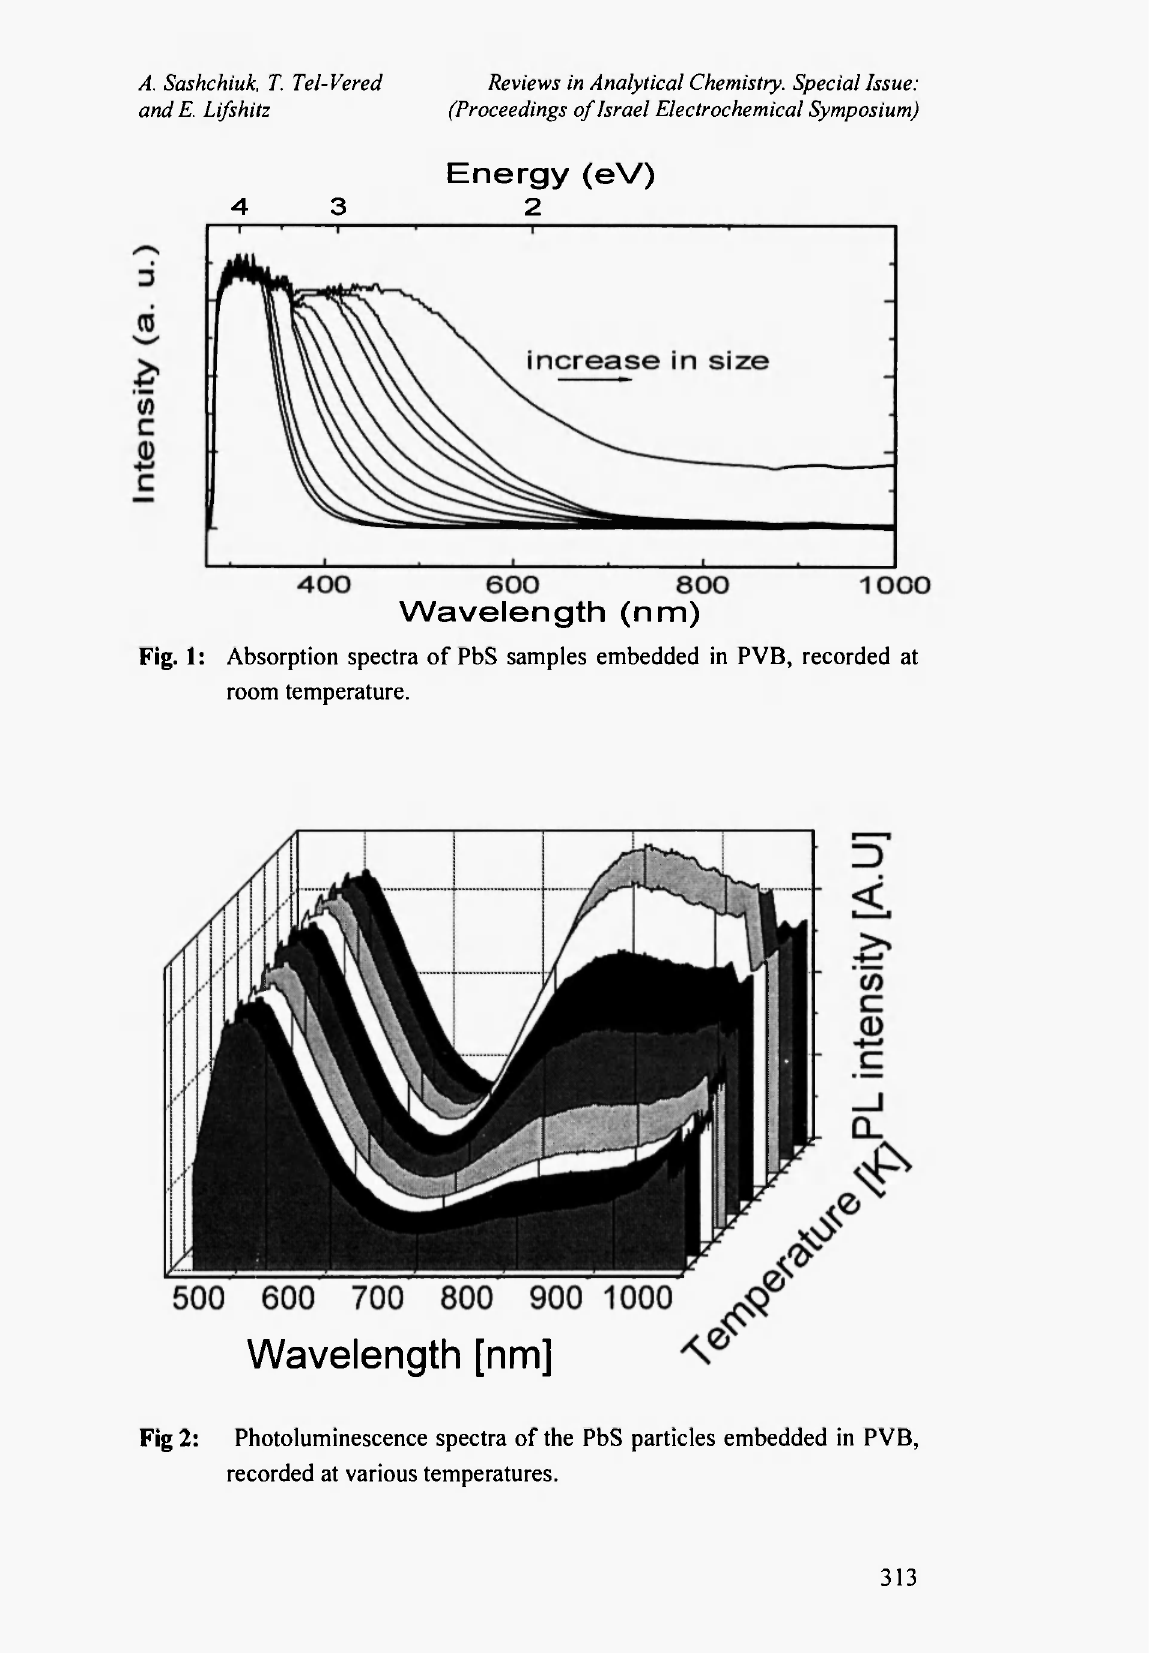
Fig 2: Photoluminescence spectra of the PbS particles embedded in PVB, recorded at various